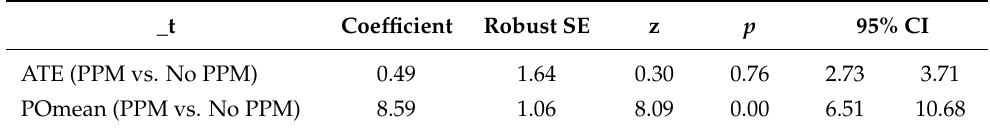
Table 4. Average effects of PPM on the